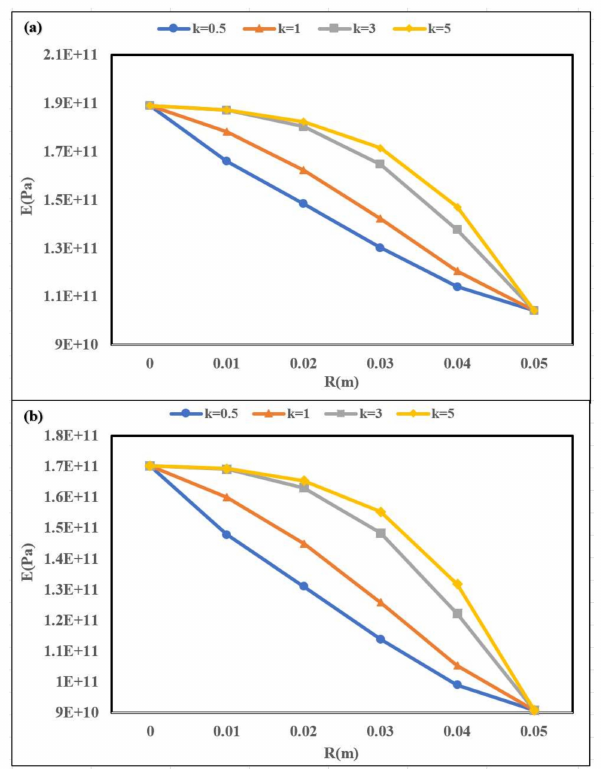
Figure 5. Variation in Young’s modulus along the radial direction of a porous FG shaft ( a ) for α = 0.1 ( b ) for α = 0.2.